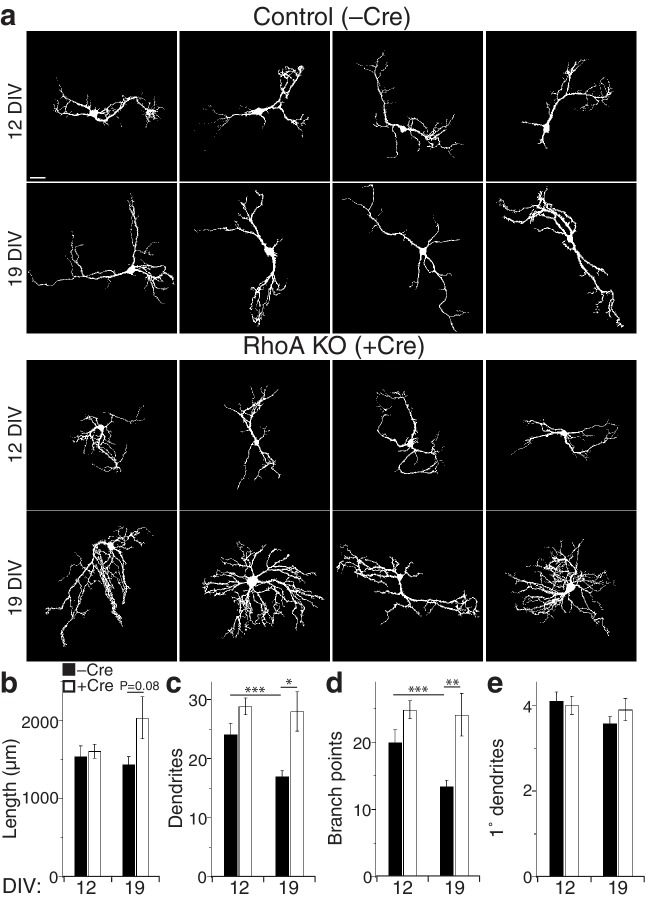
Loss of RhoA leads to late overgrowth of dendrites in mouse hippocampal neurons.(a) Representative images of hippocampal cultures from RhoAflox/flox mice transfected with EGFP alone (Control) or EGFP plus Cre recombinase in order to remove RhoA (RhoA KO) and fixed at the indicated time points. Quadruplicate exemplars are shown. Images are masked to remove axons and dendrites from other neurons. Bar is 20 µm. (b) Summary data for dendrite length. (c) Summary data for dendrite number. (d) Summary data for braanch number. (e) Summary data for 1° dendrite number. Control mouse cultures achieved stable arbor length by 12 DIV, exhibiting no further growth at 19 DIV (Panels A,B). In contrast, RhoA KO neurons were the same length as control neurons at 12 DIV, but grew between 12 and 19 DIV (panels a,b). Interestingly, control neurons exhibited decreases in both dendrite number (panels a,c) and branch points (panels a,d) from 12 to 19 DIV, but RhoA KO neurons did not (panels a,c,d). RhoA KO had no effect on the number of primary dendrites (panels a,e). These data confirm that RhoA limits dendrite growth, primarily later in development. Data are represented ± s.e.m. (***p<0.0001, **p<0.01, *p<0.05) Detailed statistics are found in Figure 3—figure supplement 3—source data 1.10.7554/eLife.47566.023Figure 3—figure supplement 3—source data 1.Statistical summary for Figure 3—figure supplement 3: ANOVA and key Tukey post-hoc tests and N and n values for Figure 3—figure supplement 3b–e.